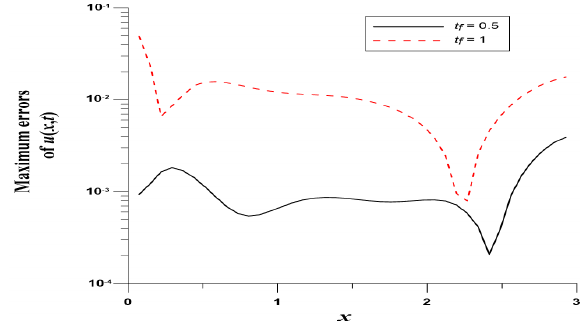
Figure 14. For Example 9 of the backward nonlocal wave problem under two-side nonlocal BCs: ME( u ) versus x with different final times.